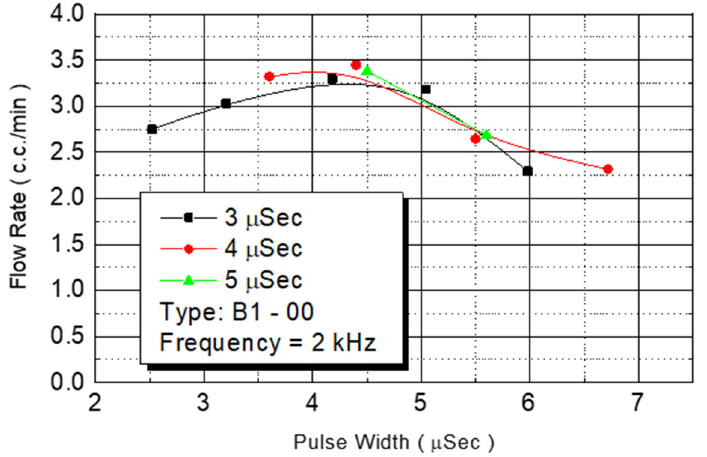
Figure 13. B1-00 flow test.